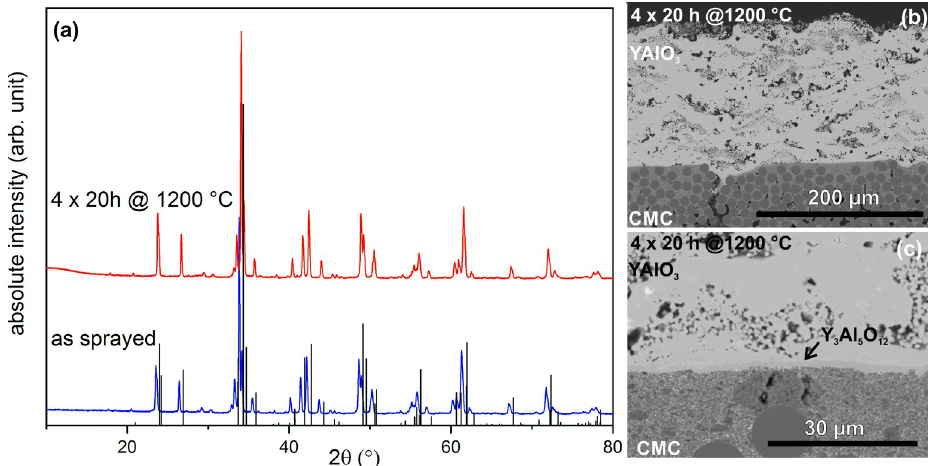
Figure 5. ( a ): XRD-measurement of the VLPPS YAlO 3 coatings in the as-sprayed and thermally treated state. ( b , c ): SEM images of the VLPPS YAlO 3 coatings after thermal treatment.